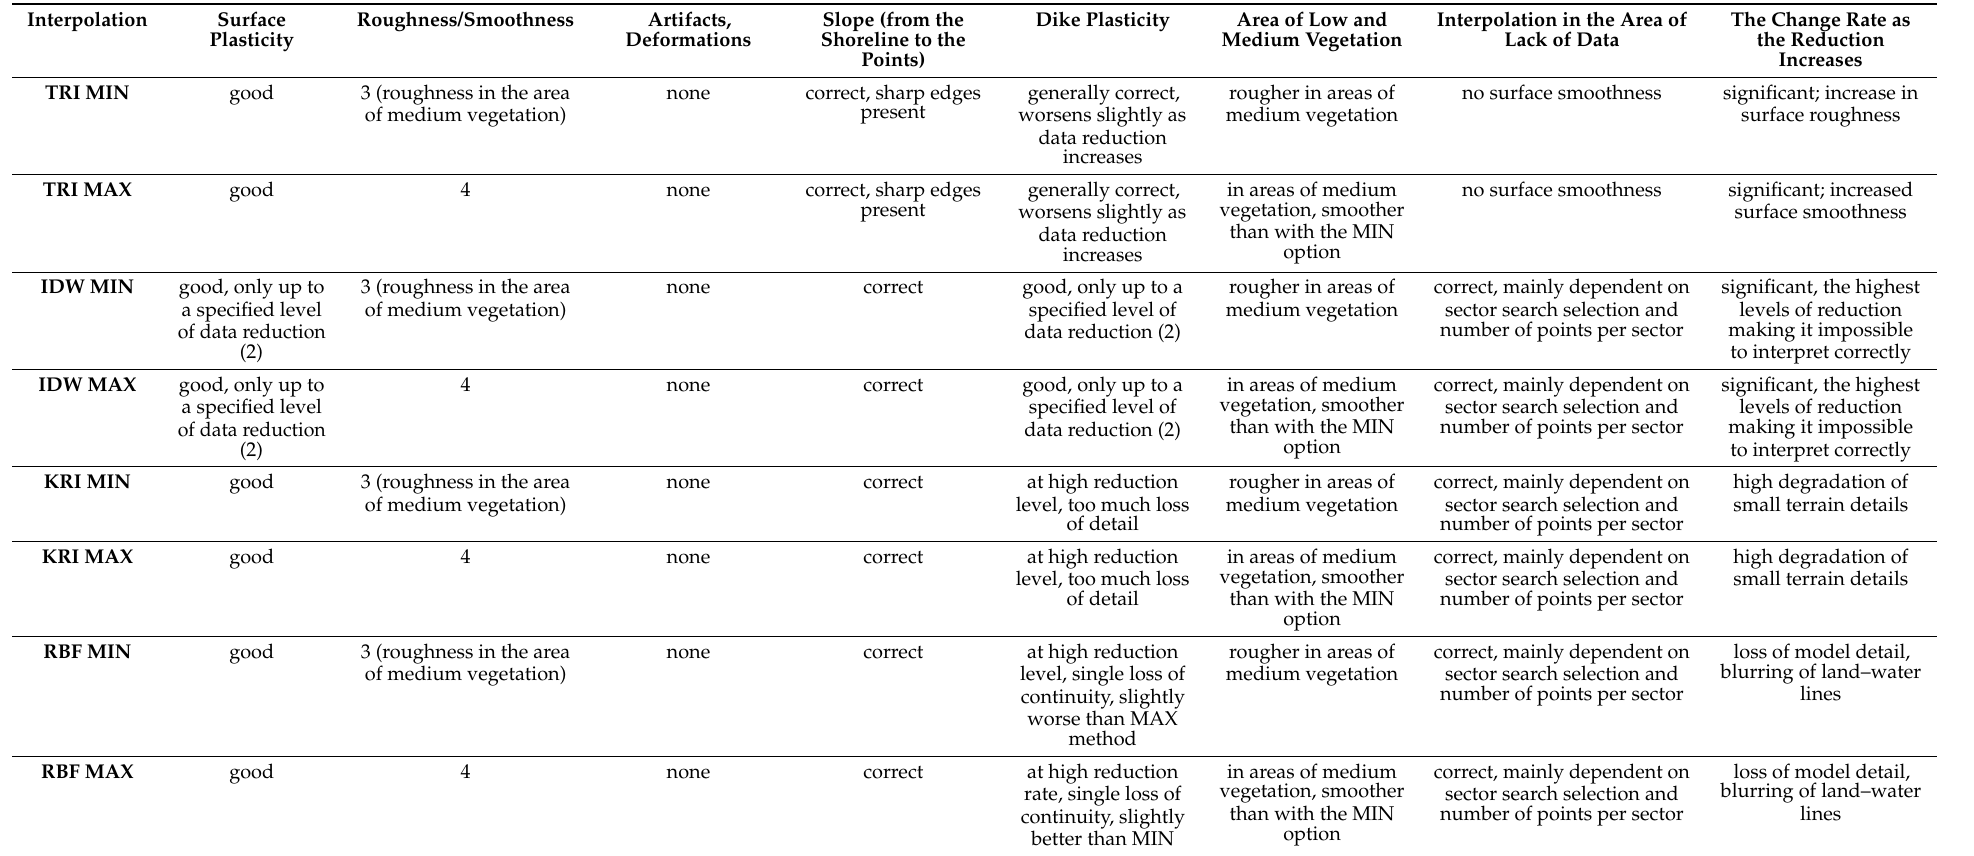
Table A2. Qualitative analysis for surfaces created from UAV